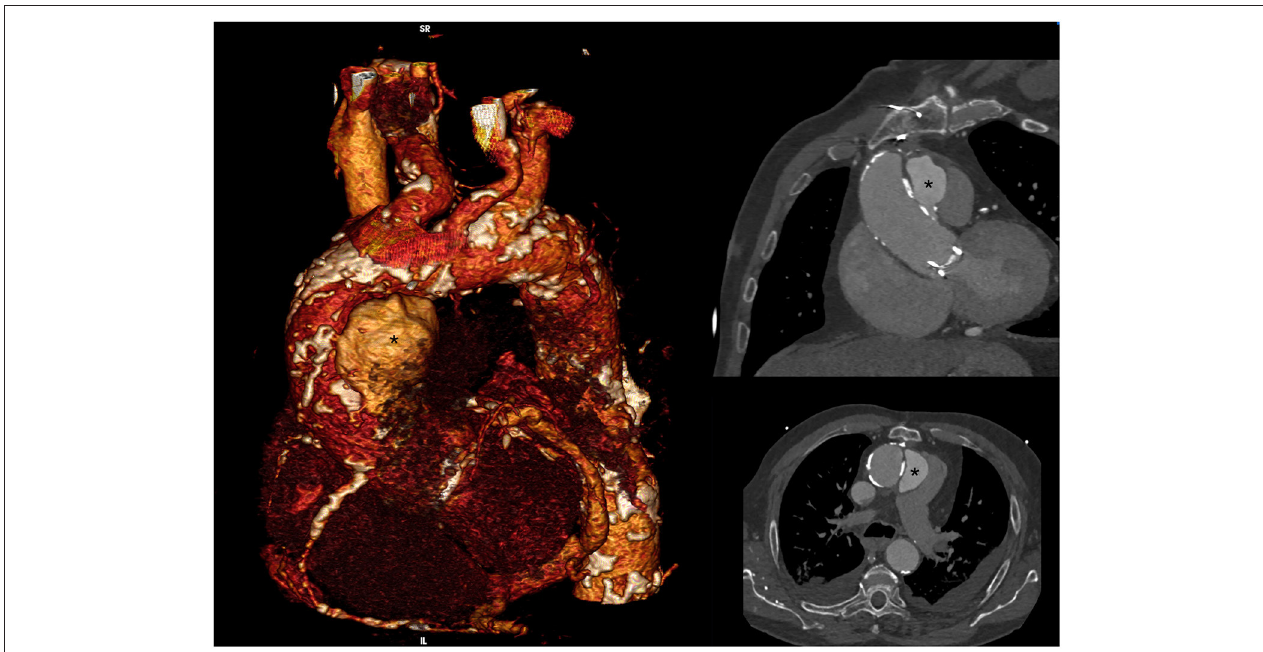
FIGURE 5 | Volume rendering and 3D MPR images of the ascending aorta and aortic arch, demonstrating the presence of severe calcific atherosclerosis and a big aortic pseudoaneurysm